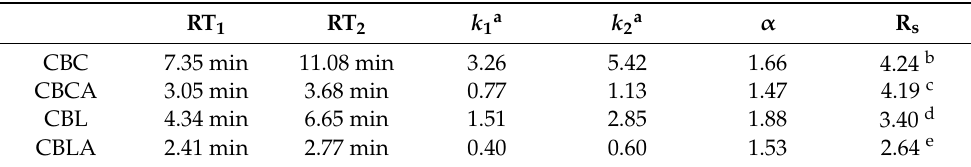
Table 4. Chromatographic performance of analytical cannabinoid separations on IK